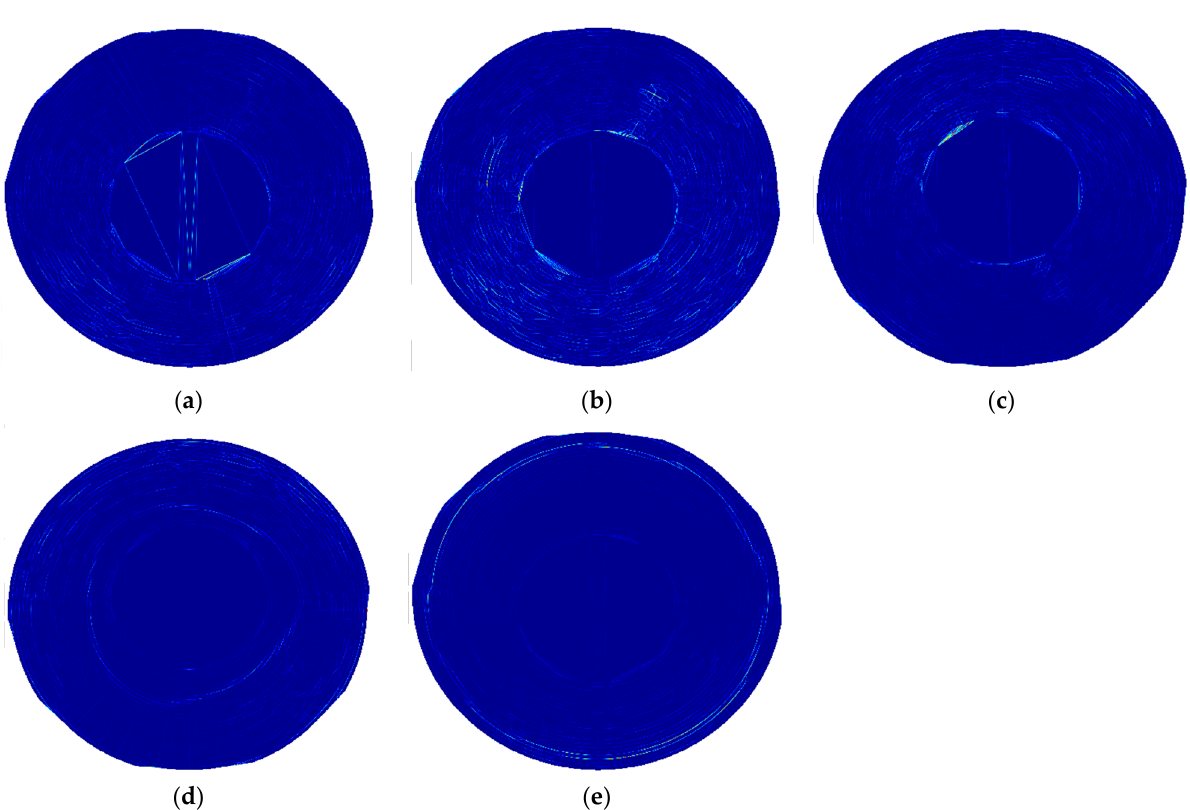
Figure 9. The interpolated mode shapes of the smaller disk: ( a – c ) subsequent considered mode shapes.